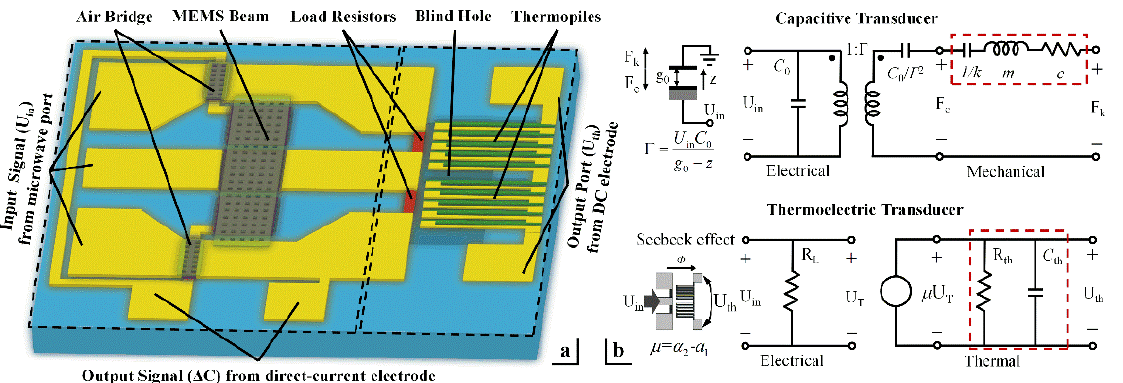
Figure 2. Cascaded MEMS demodulator: ( a ) schematic overview and ( b ) equivalent circuit.